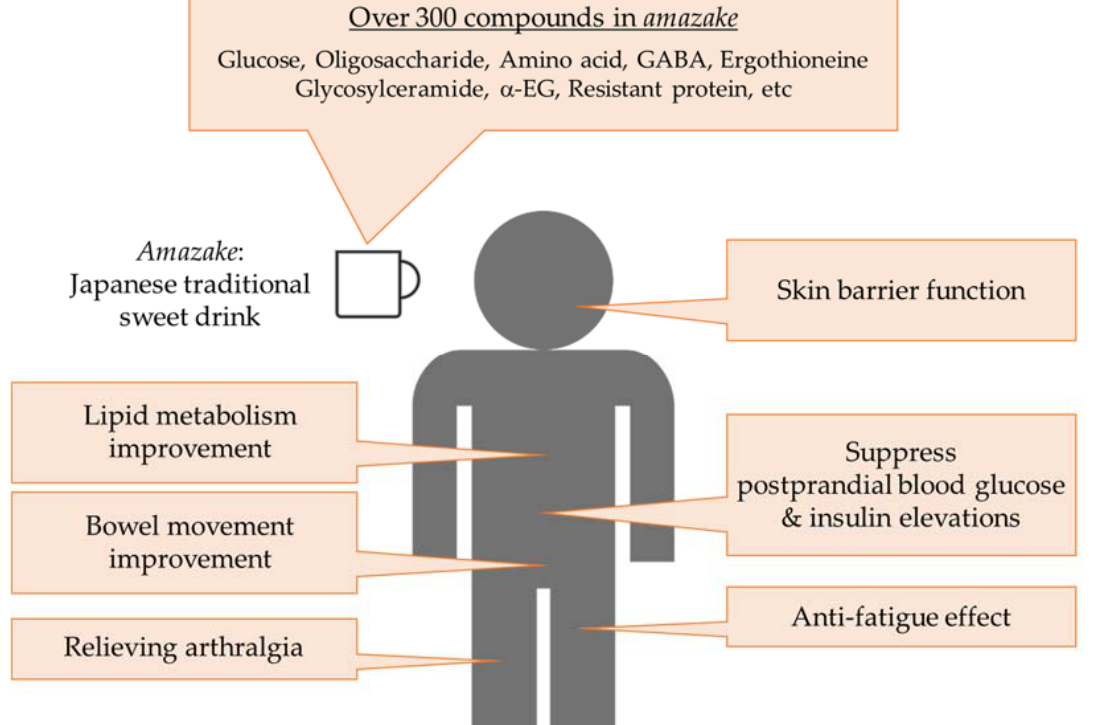
Figure 4. Summary figure describing the ingredients and functionality in amazake for human health.